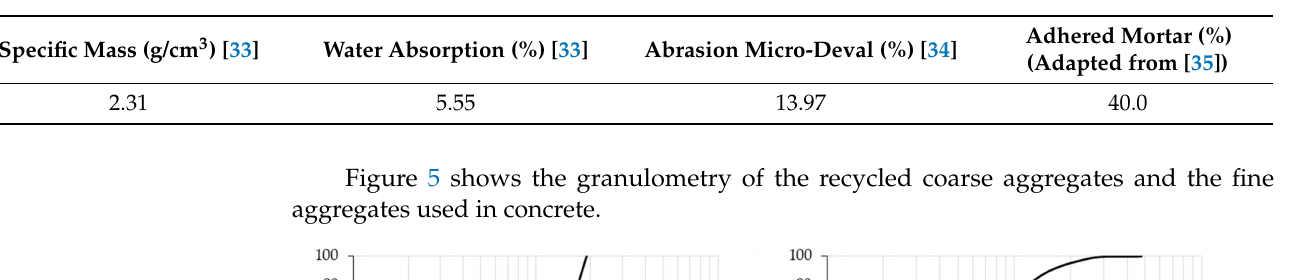
Table 3. Physical characteristics of recycled coarse aggregates.